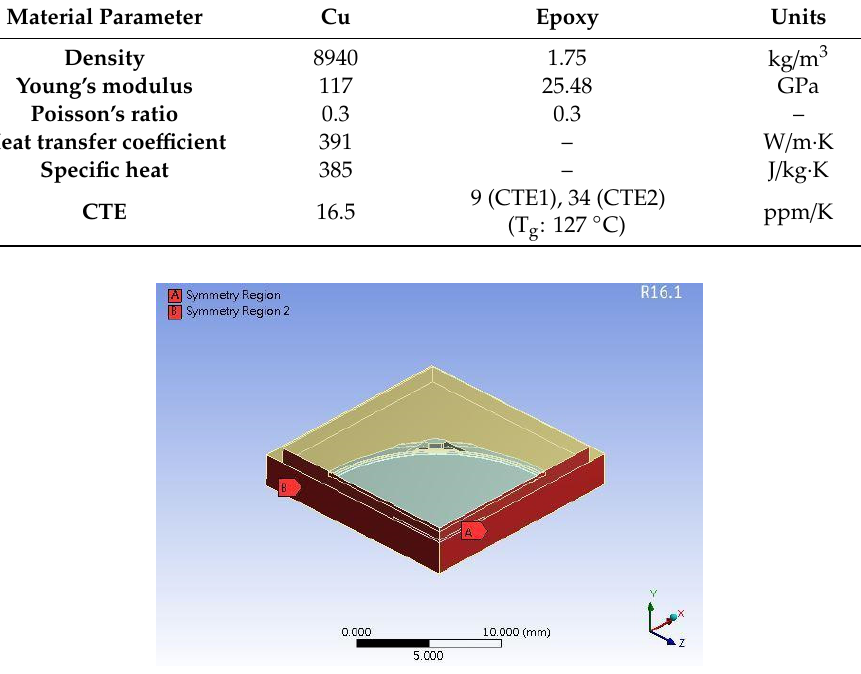
Figure 7. A simplified quarter model for molding simulation.